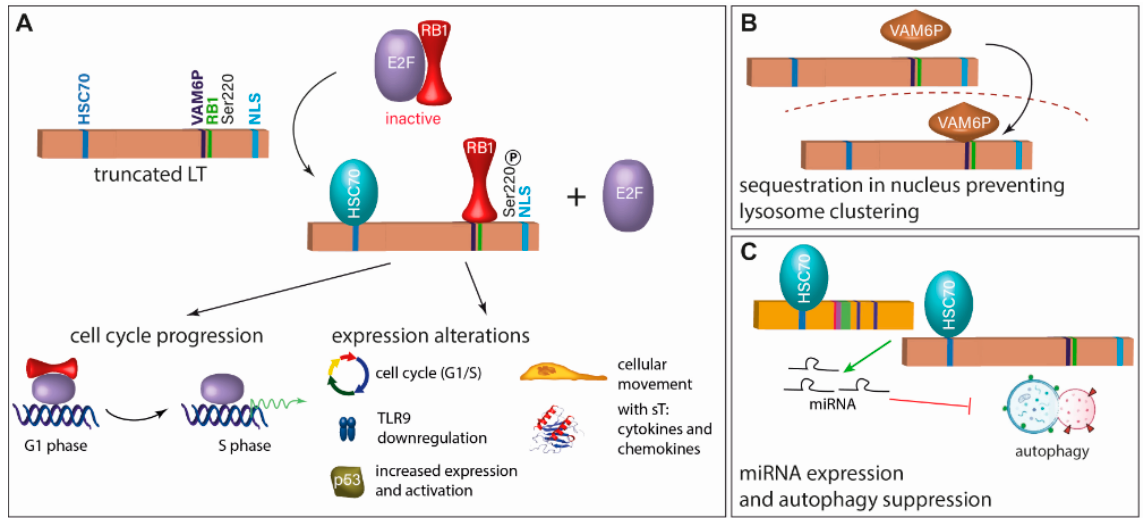
Figure 3 . Inhibition of RB1 is the crucial function of truncated LT (tLT). ( A ) For the growth-promoting function of truncated LT, it requires an intact RB1 binding site, has to interact with HSC70, and has to be phosphorylated at Serine 220 [70–72]. This leads to cell cycle progression and expression and activation of several molecules. ( B ) Another described function of tLT is binding of VAM6P (VPS39), which leads to its sequestration in the nucleus preventing lysosome clustering [73]. ( C ) tLT and sT induce expression of miRNAs which inhibit autophagy. This function is dependent on the interaction with HSC70